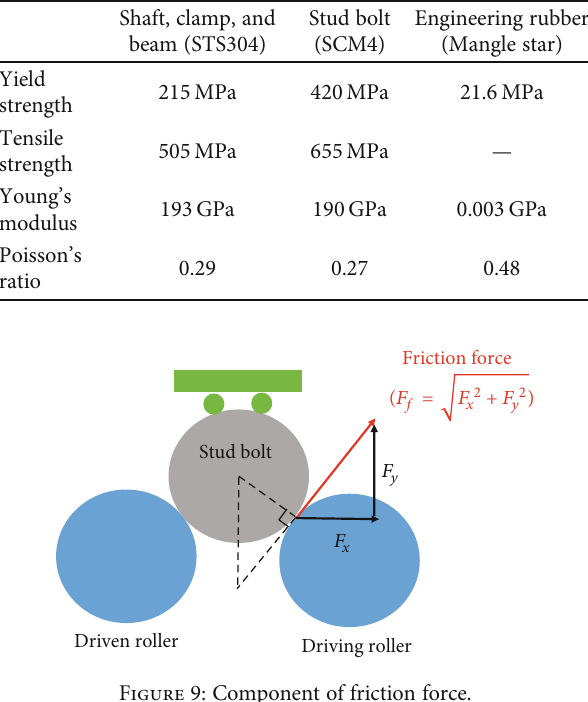
Figure 8: FEA model to obtain the optimal clamp load. Table 1: Material properties of each component.